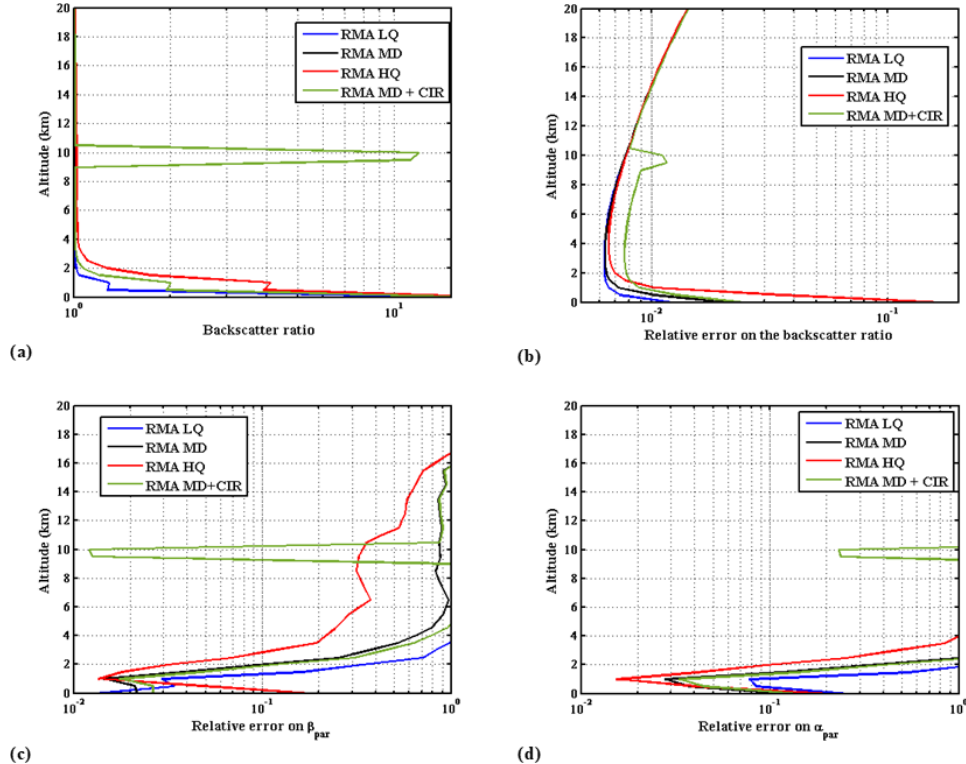
Figure 9. Actual scattering ratio. (a) Relative statistical error (standard deviation) on the scattering ratio measurement, (b) on the backscatter coefficient, (c) and on the extinction coefficient (d) for LQ, MD, HQ, and MD plus cirrus backscatter